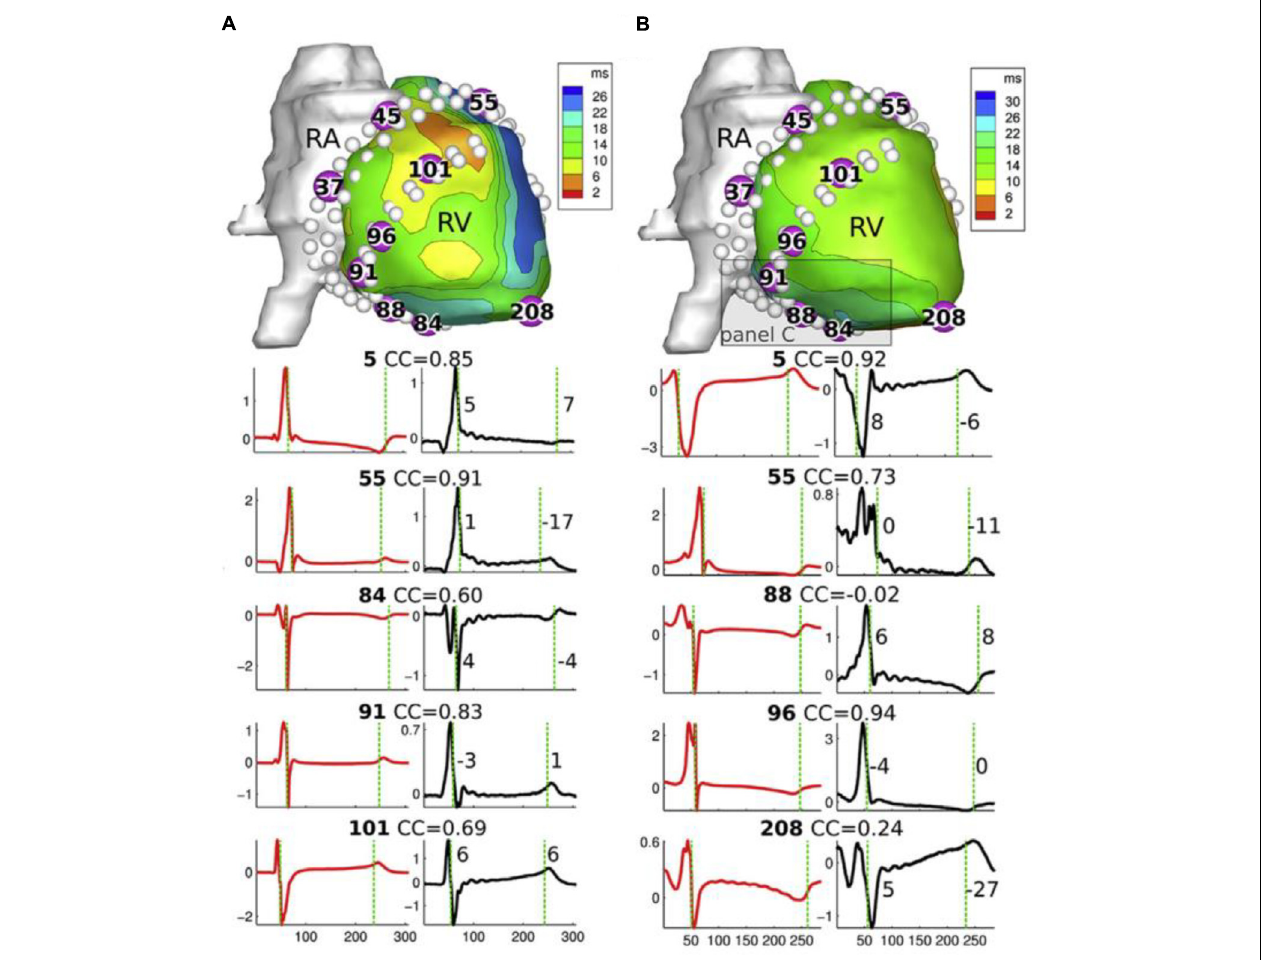
FIGURE 3 | Top: epicardial geometry with reconstructed potentials from a canine in vivo study, for a sinus beat (A) and a LV-paced beat (B) . White dots indicate the position of invasive electrodes used for validation recordings. Bottom: recorded (red) and ECGI-reconstructed (black) electrograms for electrodes numbered in geometry above. CC, correlation coefficient between recorded and reconstructed electrograms. RA, right atrijm; RV, right ventricle. Adapted with permission from Cluitmans et al.